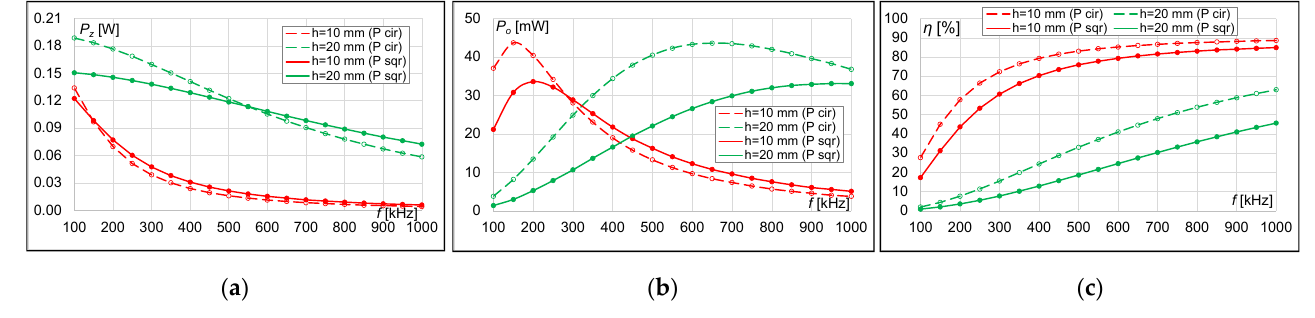
Figure 22. Results for the periodic system with circular or square coils with r = 20 mm and the number of turns n = 50 at two distances ( h = 10 mm and h = 20 mm): ( a ) transmitter power, ( b ) receiver power, ( c ) power transfer efficiency.